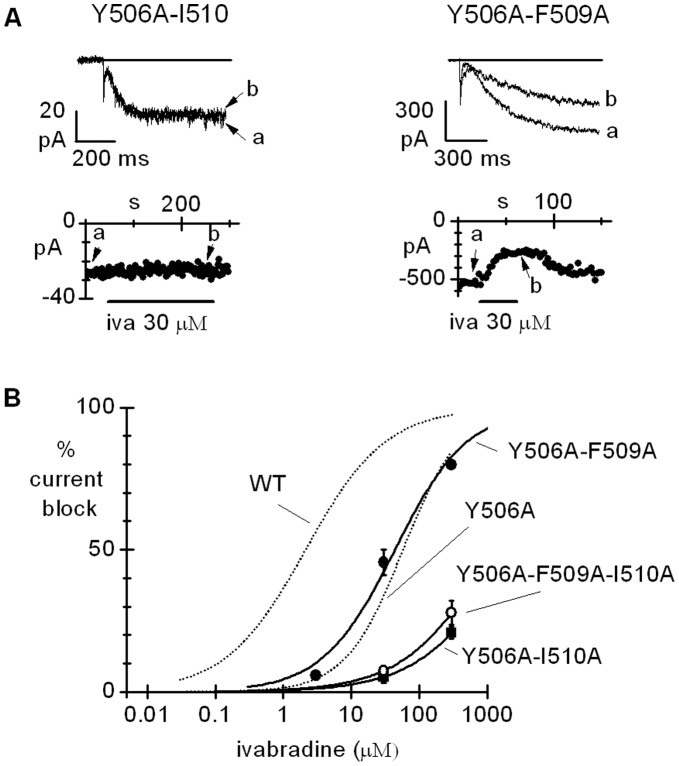
Block of double (Y506A-I510A and Y506A-F509A) and triple (Y506A-F509A-I510A) mutant channels by ivabradine.A, top, sample currents recorded at −140 mV from the two double mutant channels Y506A-I510A and Y506A-F509A in control (a) and after steady-state block by ivabradine 30 µM (b); A, bottom, time course of currents at −140 mV during ivabradine perfusion. B: dose-response relations; Hill fitting (full lines) yielded IC50, nH values of 2213.0 µM, 0.7, 42.5 µM, 0.8, and 1215.0 µM and 0.68 for Y506A-I510A, Y506A-F509A, and Y506A-F509A-I510A respectively. Hill fitting of WT and Y506A block from Fig. 2 also drawn for comparison (dotted lines). The two double-mutant curves are significantly different between themselves and from that of WT channels (P<0.05); the Y506A-I510A and the Y506A-F509A-I510A curves are not significantly different (P<0.05).